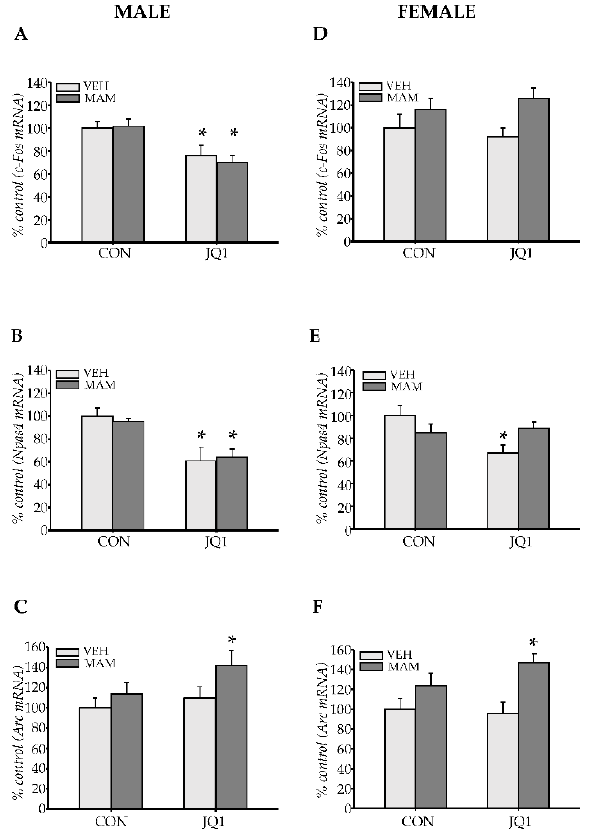
Figure 6. The effects of an adolescent JQ1 administration on early gene expression ( c-Fos , Arc , Npas4 ) in the adult medial prefrontal cortex in the MAM-E17 model of schizophrenia. The rats (males: A – C and females: D – F ) were exposed to JQ1 or vehicle (CON) in early adolescence (P23–P29), and the analyses were performed in rats at P110. ( A – C ) c-Fos , Arc , and Npas4 expression in males, respectively. ( D – F ) c-Fos , Arc , and Npas4 expression in females, respectively. The data are expressed as percentage of VEH-CON. Each data point represents the mean ± SEM; n = 6 per group * p < 0.05 vs . VEH-CON (two-way ANOVA followed by a Tukey test).